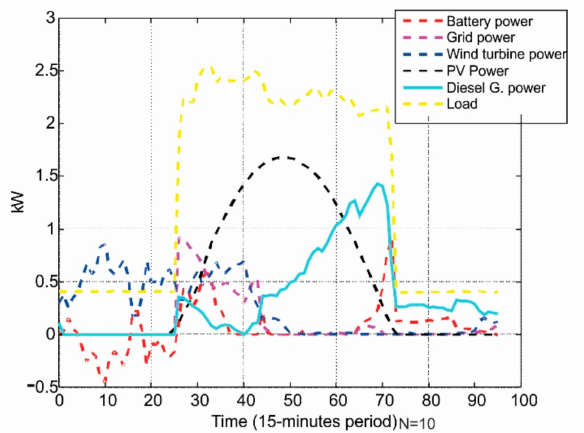
Figure 9. Forecasting power for the microgrid with N =